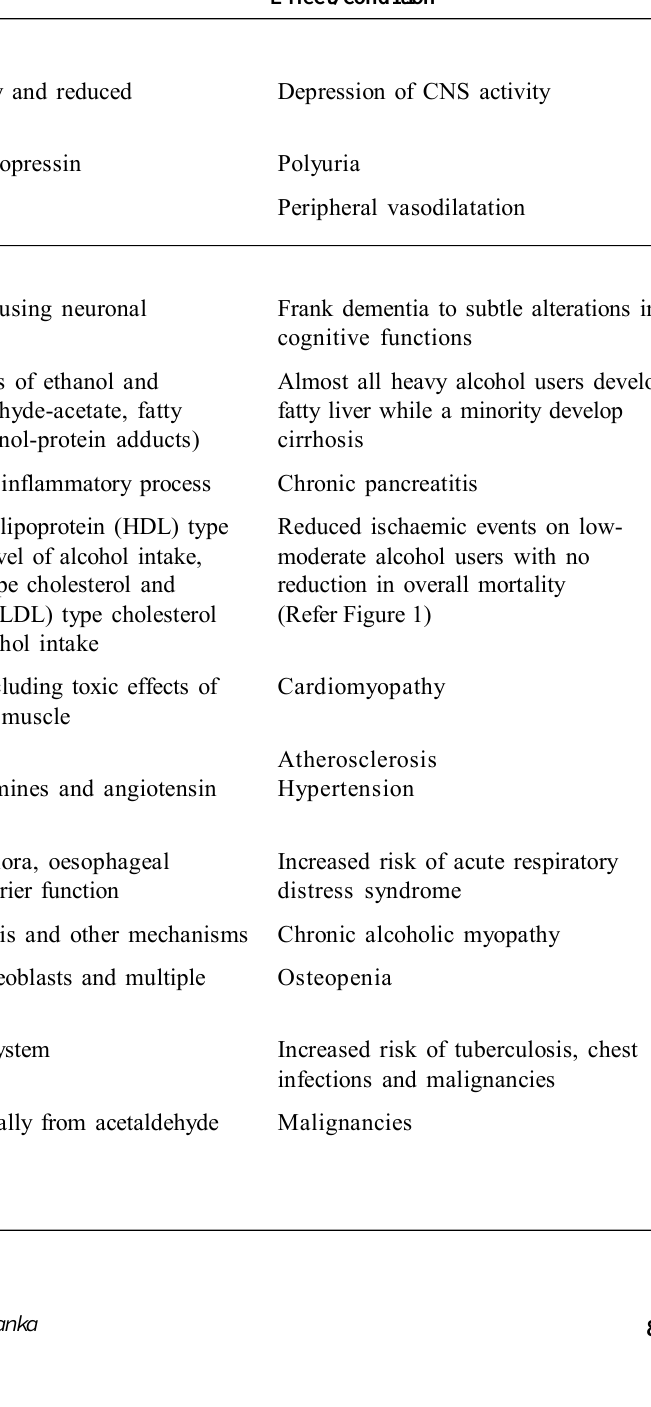
Table 2. Effects of alcohol on individual organs